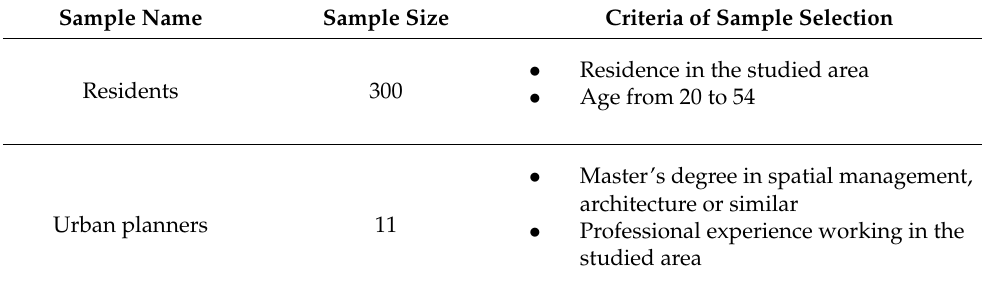
Table 1. Samples characteristic.